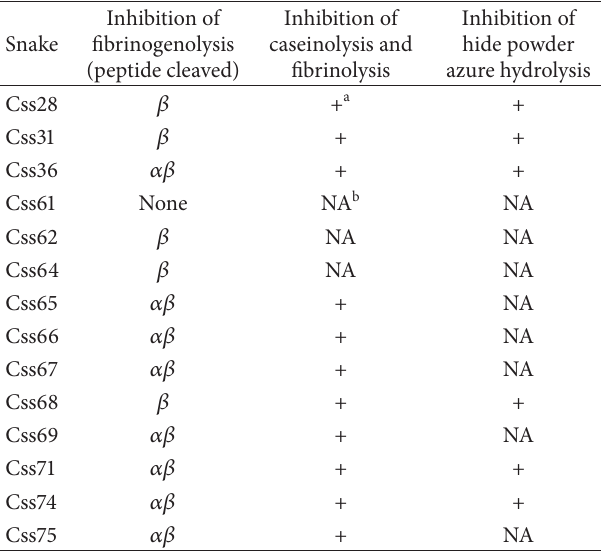
Table 4: Proteolytic activity inhibition of the C. s. scutulatus venoms by EDTA. Inhibition of Snake